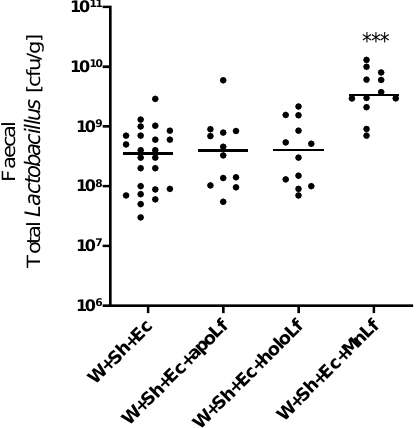
Figure 5. Fecal population numbers of total lactobacilli for groups with lactoferrin supplemen- tation. *** p < 0.01 vs. W+Sh+Ec and W+Sh+Ec+apoLf and W+Sh+Ec+holoLf. W+Sh+Ec-target model group weaned with administration of both intraperitoneal S. haemolyticus 186 and oral E. coli 3A/1. W+Sh+Ec+apoLf-p.o. metal-depleted apoLf, W+Sh+Ec+holoLf-p.o. iron-saturated holoLf, W+Sh+Ec+MnLf-p.o. manganese-saturated